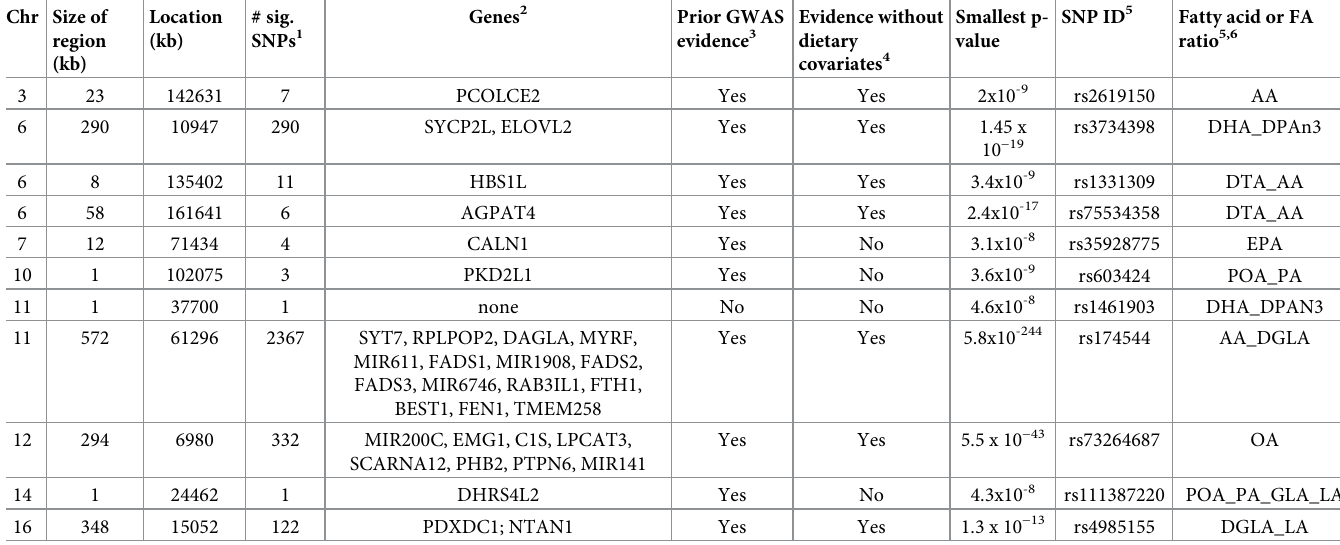
Table 1. Summary of 11 significant loci for FAs and FA ratios with dietary